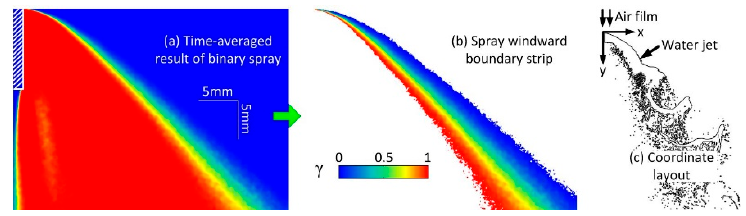
Figure 6. Extraction of the windward boundary band [20].